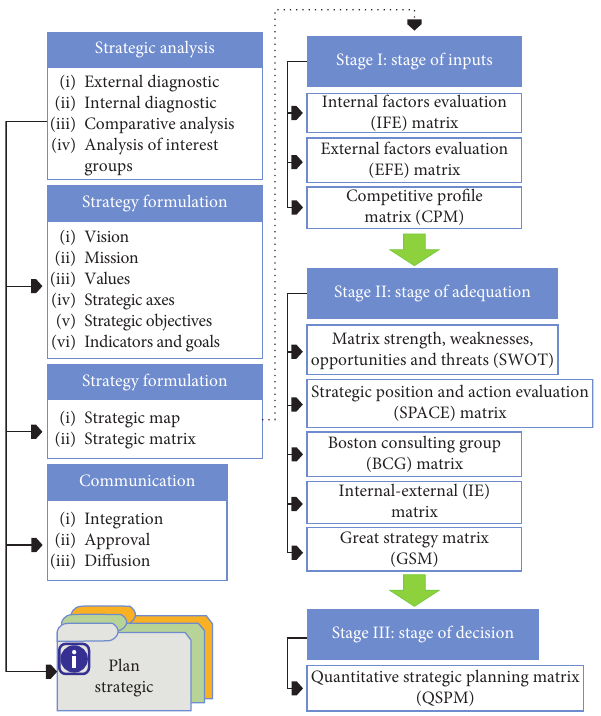
Figure 1: Stages of the strategic